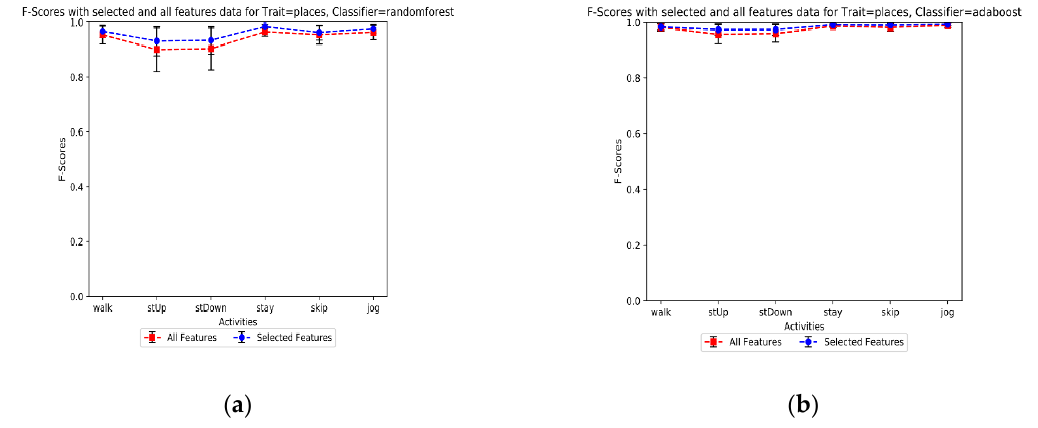
Figure 8. F-Score comparison for different activities. ( a ) The RF classifier model performance; ( b ) the AdaBoost classifier model performance. Table 8. The sensitivity of detectors to the size of features and activity.